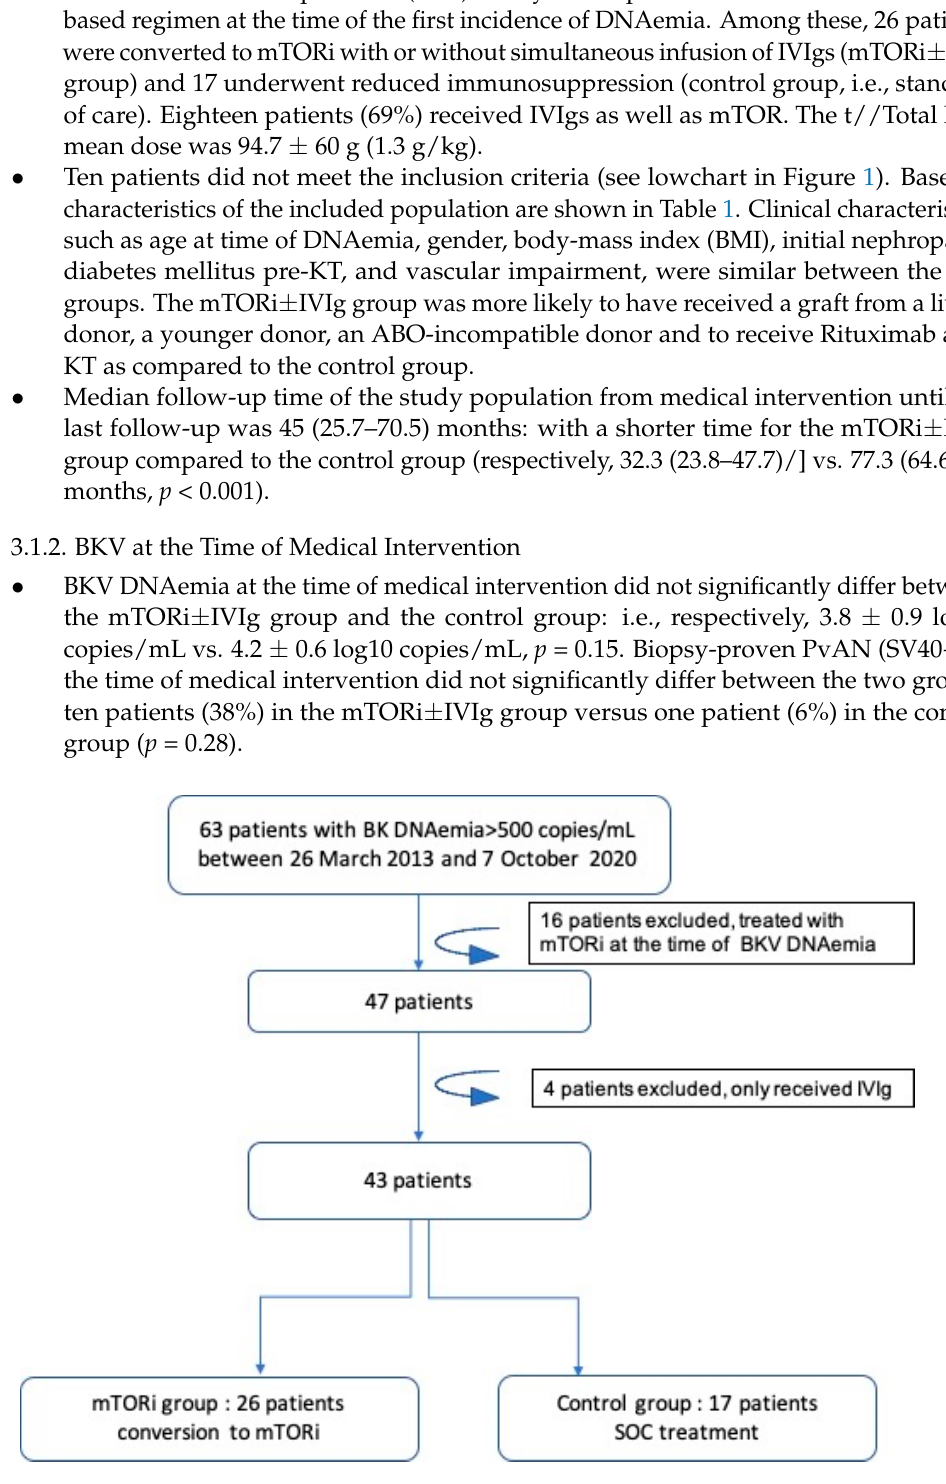
Figure 1. Flowchart of patients. mTORi: mammalian target of rapamycin inhibitor; IVIg: intravenous immunoglobulins; SOC: standard-of-care treatment.